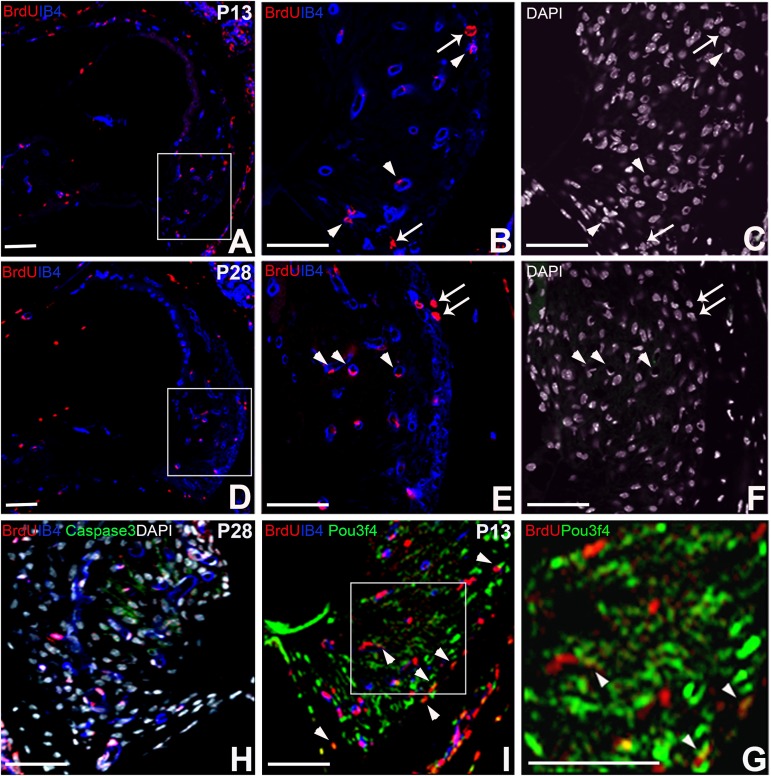
Characterization of long-term BrdU label retaining cells in the SL.Double labelings of BrdU/IB4 (A-F), triple labeling of BrdU/IB4/Caspase3 (H), BrdU/IB4/Pou3f4 (I and G) were shown. Nuclei were stained using DAPI. BrdU positive cells were co-labeled with anti-DAPI (B, C, E, F and H). 11.44 ± 0.80% (at P13) or 9.33 ± 1.03% (at P28) of BrdU+ cells were also positive for IB4+ (B, E, arrowheads). BrdU+IB4- cells were negative for Caspase3, indicating that the labeling was not due to apoptosis. 3.52 ± 0.68% (at P13) of BrdU+IB4- cells were positive for Pou3f4 (I and G arrowheads), indicating the SL fibrocytes proliferate during the neonatal stages. Scar bar = 100μm.